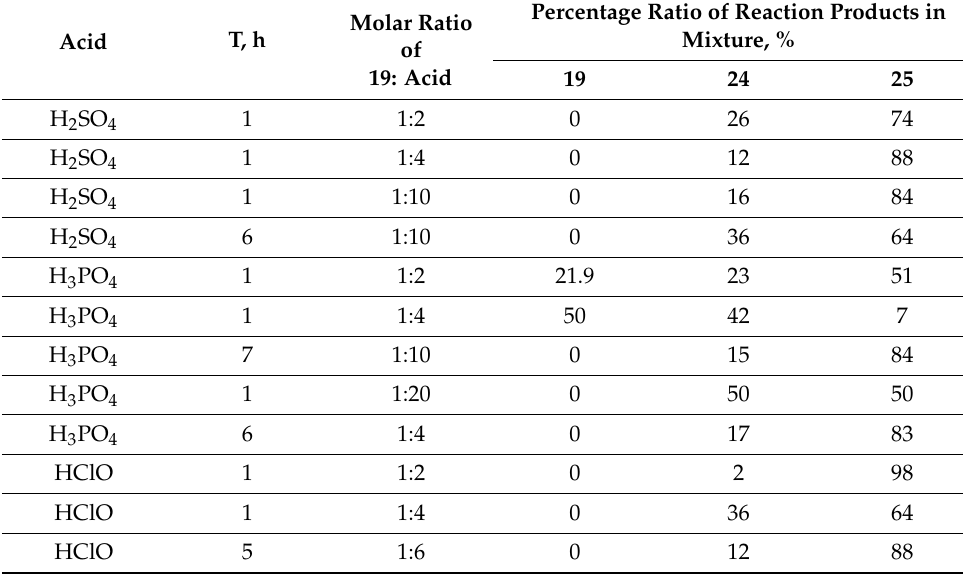
Table 4. Acetylation of 19 with acetic anhydride at T = 90 ◦